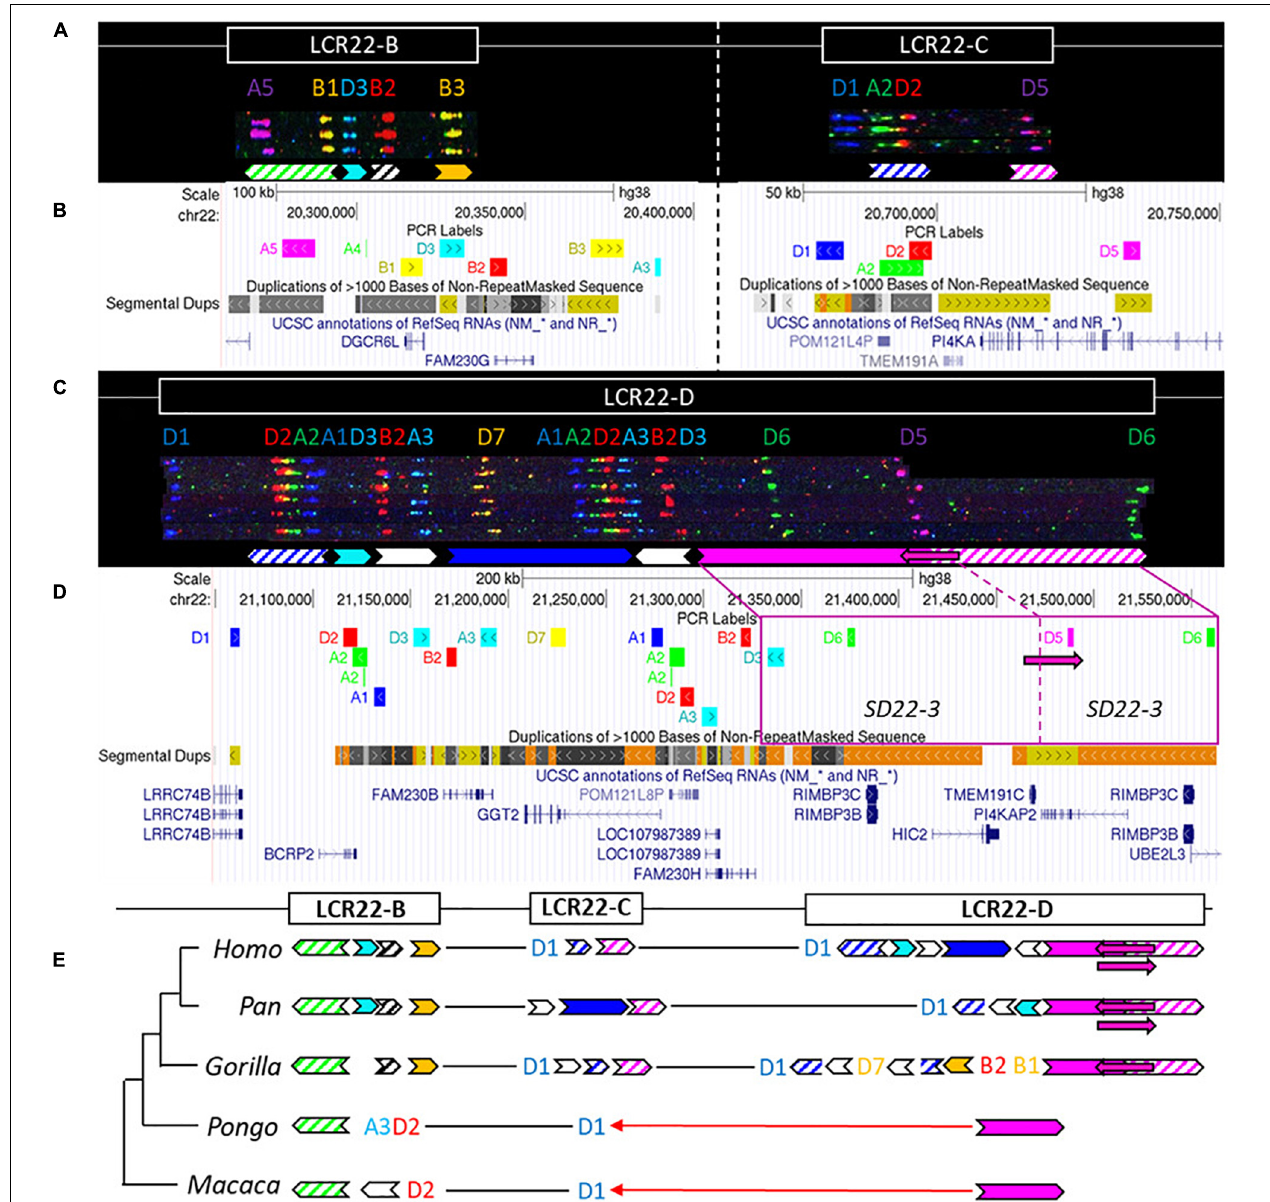
FIGURE 4 | Human duplicon structure and evolutionary analysis of LCR22-B, -C, and –D. (A) De novo assembly of a LCR22-B (left) and LCR22-C (right) haplotype. SD22 duplicons are assigned to specific probe combinations, based on the probe composition in LCR22-A ( Figure 3A ). (B) UCSC Genome Browser hg38 reference screenshot of LCR22-B (left) and LCR22-C (right), with tracks for fiber-FISH probe BLAT positions, segmental duplications, and RefSeq genes. (C) De novo assembly of an LCR22-D haplotype based on matching colors and distances between the probes. SD22 duplicons are assigned to specific probe combinations. (D) UCSC Genome Browser hg38 reference screenshot, with tracks for fiber-FISH probe BLAT positions, segmental duplications, and RefSeq genes. The extended SD22-3 duplicon is decomposed to the corresponding fiber-FISH probes in the reference genome. (E) Evolutionary tree representation of the observed LCR22-B, -C, and -D haplotypes. Filled, colored arrows represent copies of duplicons, and hatched arrows represent partial copies of duplicons of the same